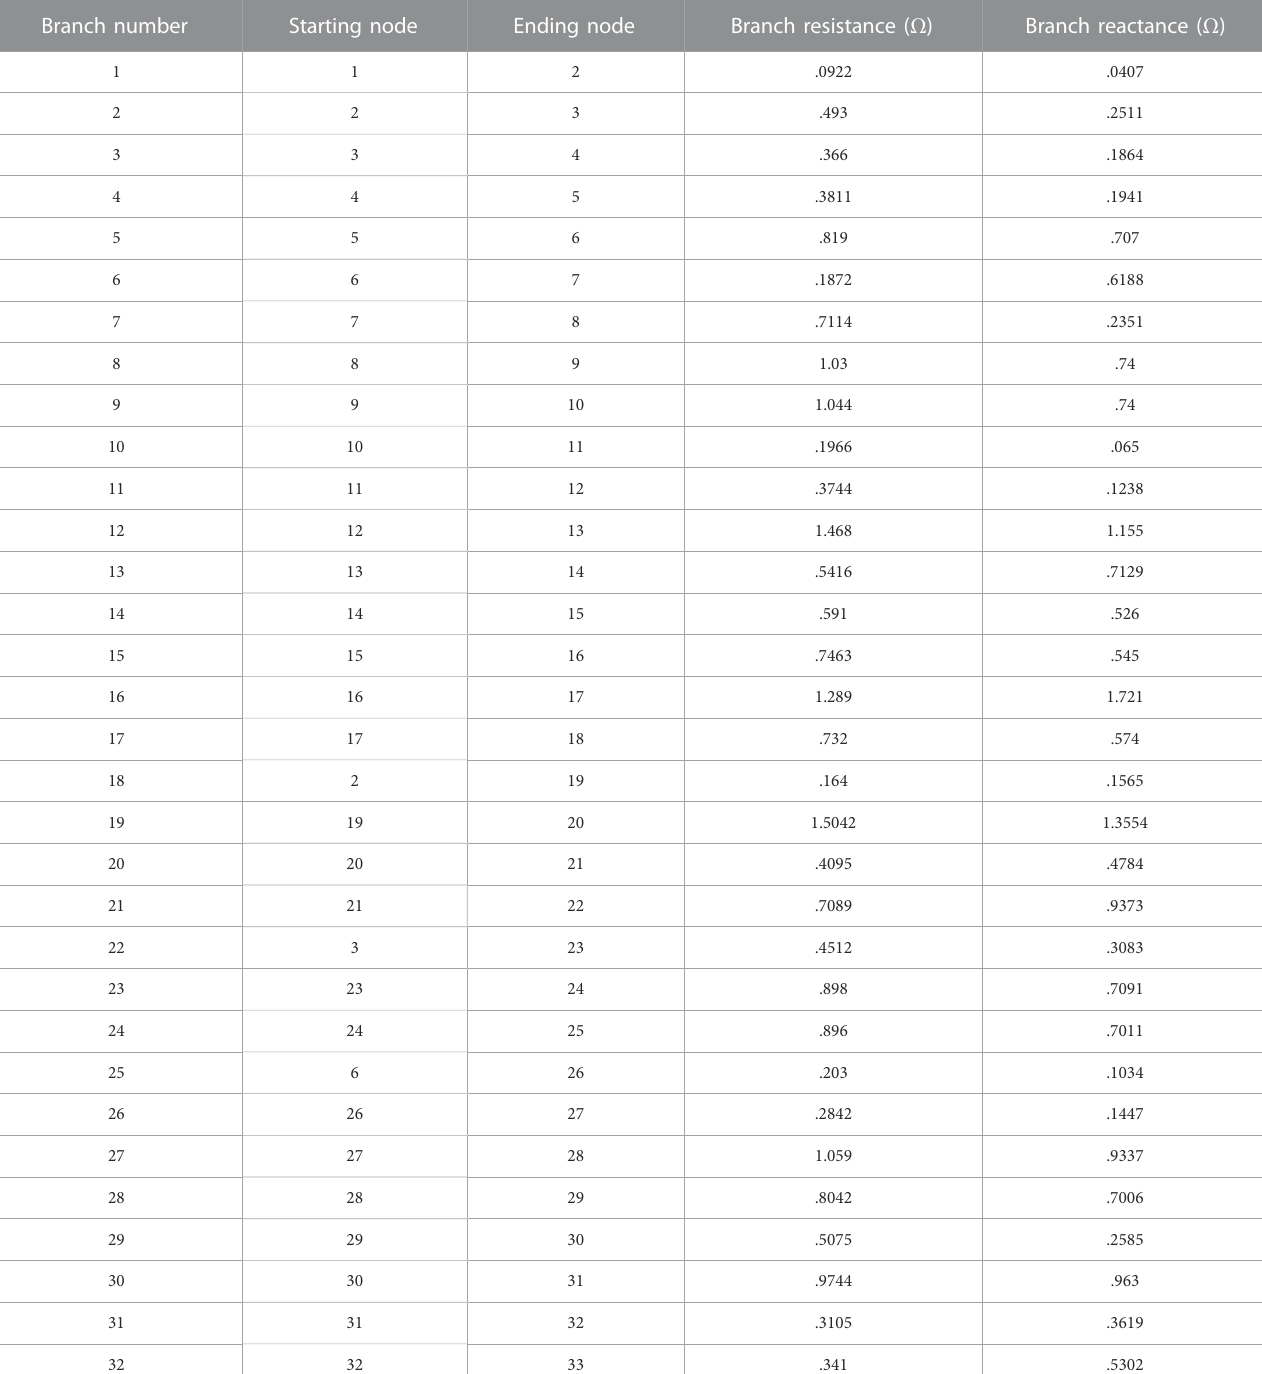
TABLE 2 Branch parameters of the standard IEEE 33-node DN system. Branch